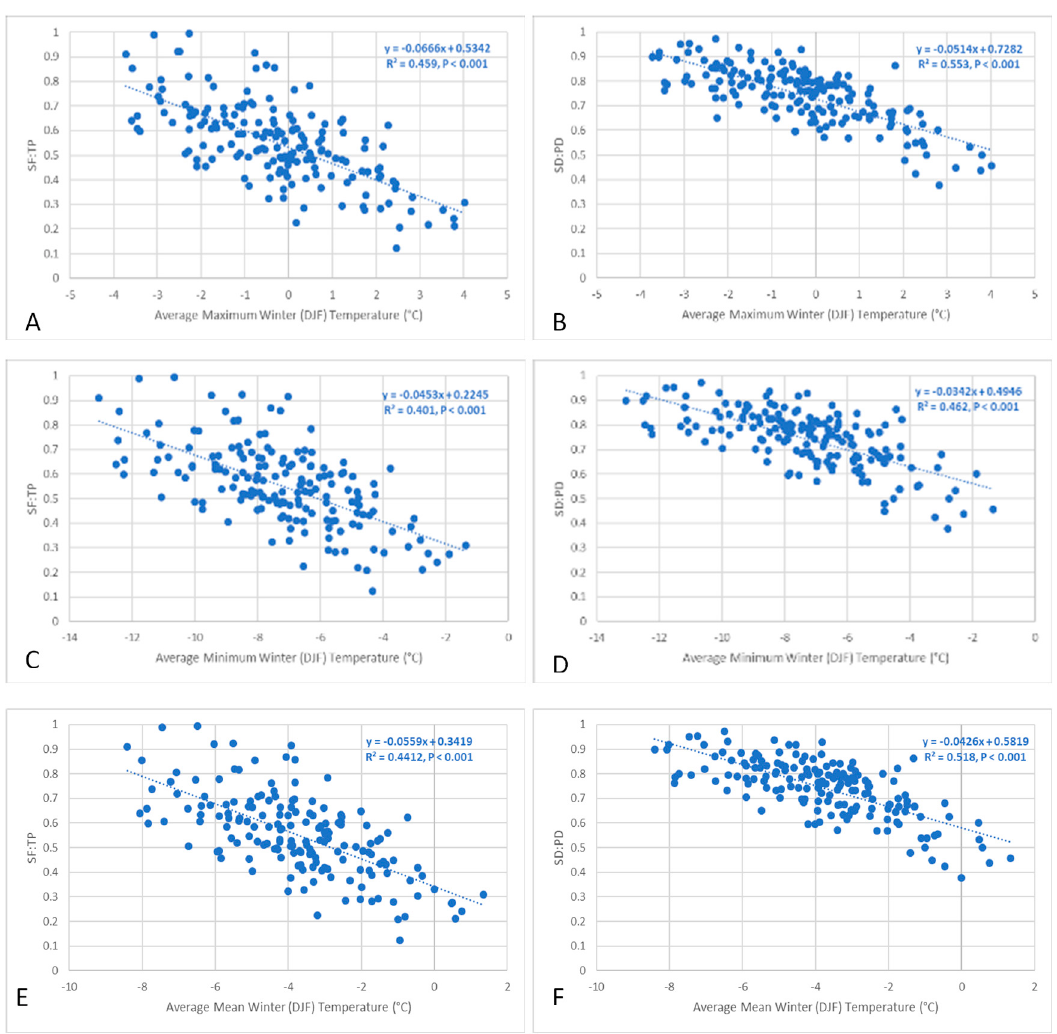
Figure 4. Correlations between winter temperatures (Tmax, Tmin, Tmean) with the snowfall to total precipitation (SF:TP) ratio ( a,b,c ) and with the snow days to precipitation days (SD:PD) ratio ( d,e,f ) in Toronto (1849–2017).